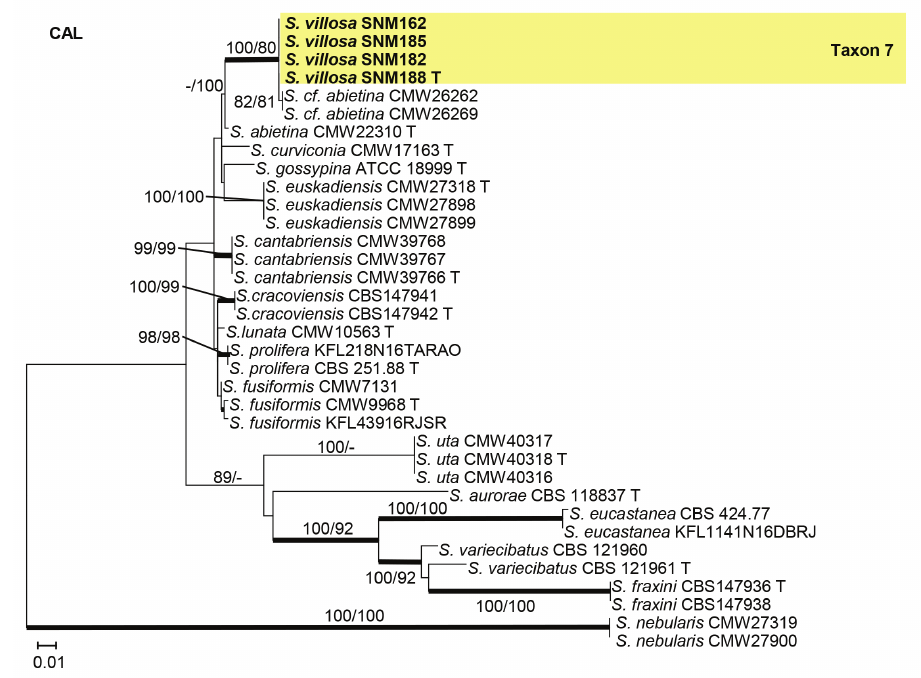
Figure 8. Maximum likelihood phylogeny of Sporothrix gossypina species complex using partial CAL gene region. The isolates recovered in this study are highlighted in color and in bold font. ML and MP bootstrap support values ≥ 75 are indicated at the nodes as ML/MP. Bold branches indicate posterior probabilities values ≥ 0.9. T indicates ex-type